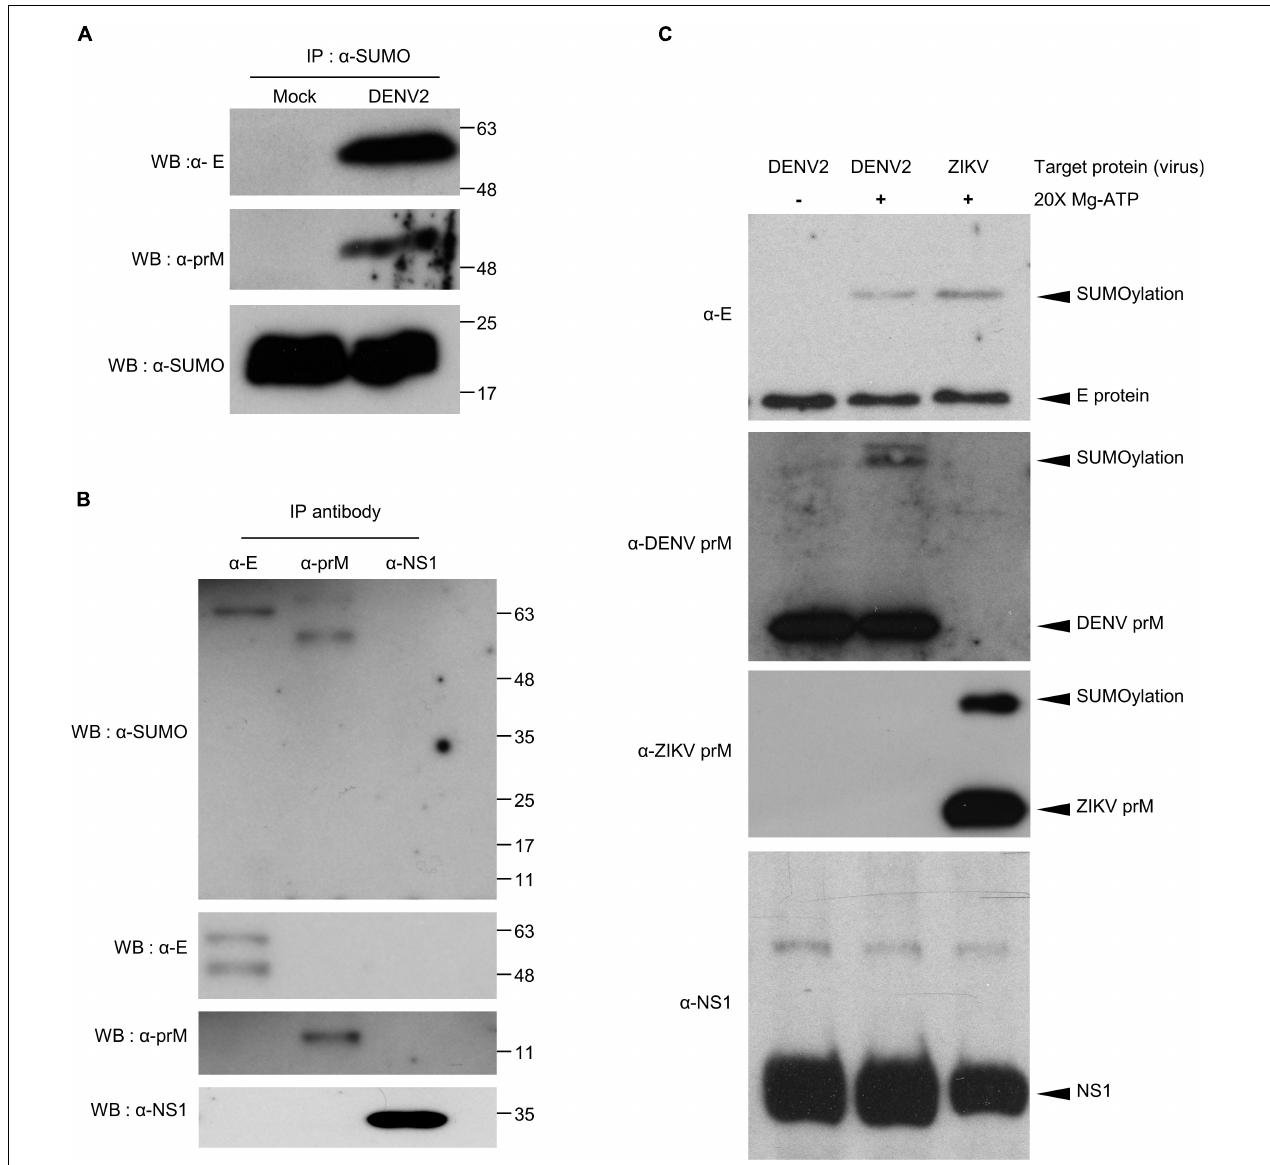
FIGURE 4 | Covalent modification of DENV2 and ZIKV E and prM proteins by SUMO protein in virus-infected mosquitoes. (A,B) Seven days post virus injection (2000 pfu/mosquito), mosquito whole body cell lysate was collected and incubated at 65 ◦ C for 15 min. The denatured proteins were immunoprecipitated using antibodies specific to SUMO protein (A) and DENV proteins E, prM, and NS1 (B) . The immunoprecipitation products were analyzed via western blot with anti-SUMO, anti-E, anti-prM, and anti-NS1 antibodies. (C) In vitro SUMOylation assay of DENV proteins, E, prM, and NS1. The medium from DENV infected C6/36 cells was collected and examined via our in vitro SUMOylation assay. We used a western blot to probe the reaction mixture with anti-E, anti-prM, and anti-NS1 antibodies. A reaction without ATP was used as a negative